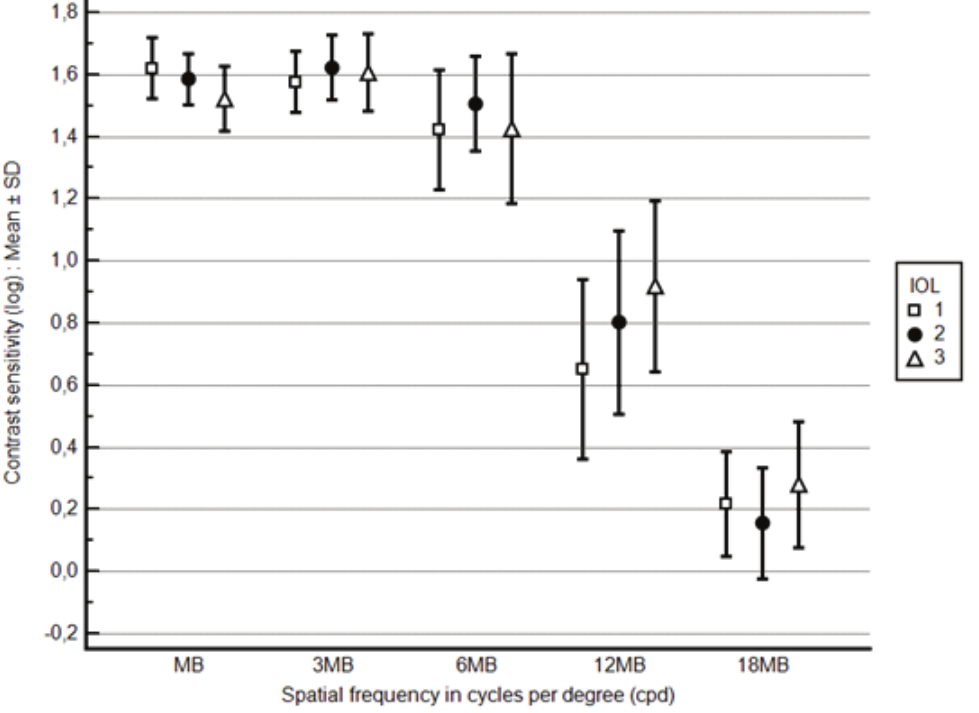
Figure 3. Postoperative contrast sensitivity (log) under mesopic with glare conditions (3 cd/m2 with glare) in various spatial frequencies for the IOLs included in the study [IOL1 = Bioline Yellow Accurate (i-medical, Germany), IOL2 = BioAcryl 60125 (Biotech, France), IOL3 = H65C/N (PhysIOL,